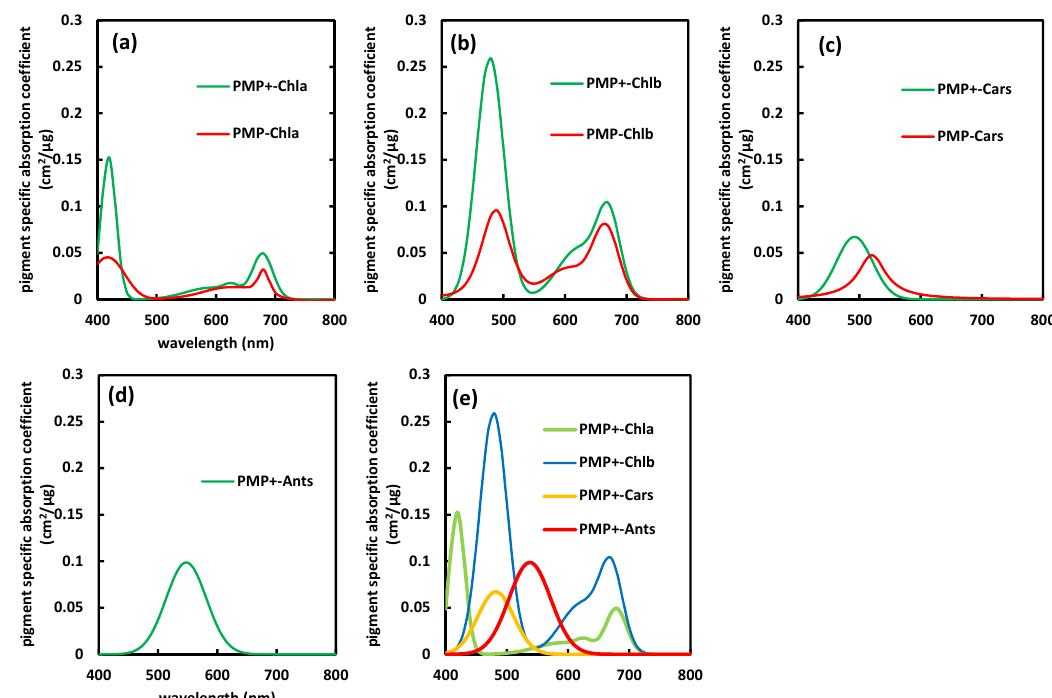
Figure 4. The spectral characteristics of the determined parameters in vivo for PROSPECT-MP (PMP) from Zhang et al. [28] and PROSPECT-MP + (PMP + ): ( a ) Chla specific absorption coe ffi cient ( K Chla ); ( b ) Chlb specific absorption coe ffi cient ( K Chlb ); ( c ) Cars specific absorption coe ffi cient ( K Cars ); ( d ) Ants specific absorption coe ffi cient ( K Ants ); and ( e ) the overlapping characteristics of the determined pigment absorption coe ffi cients from PMP + .